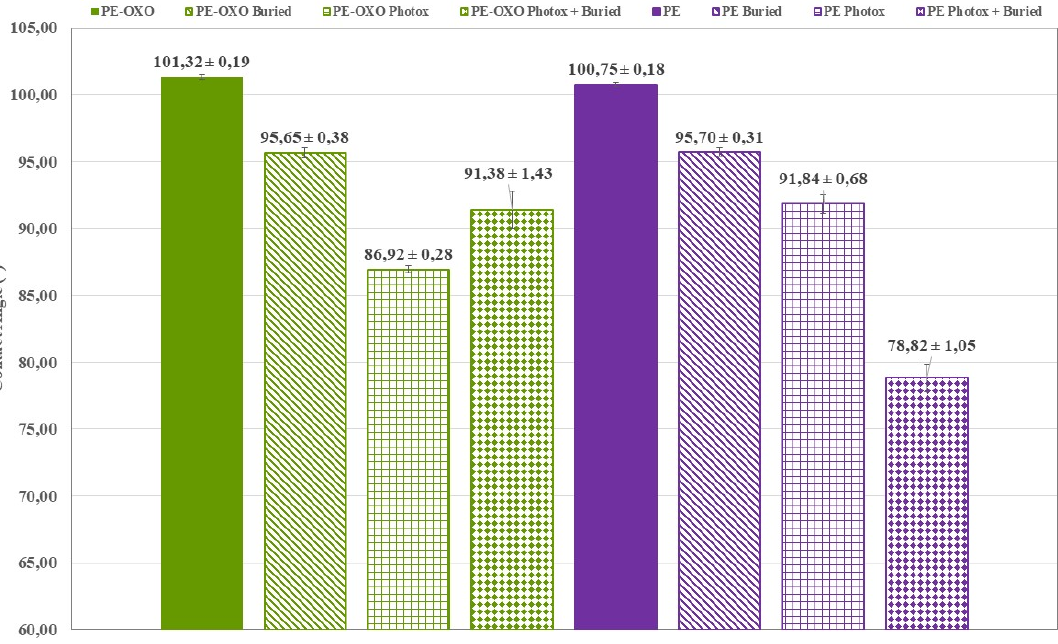
Figure 7. Average contact angle values for the film samples PE-OXO and PE, virgin, buried (125 days) and photo-oxidized.